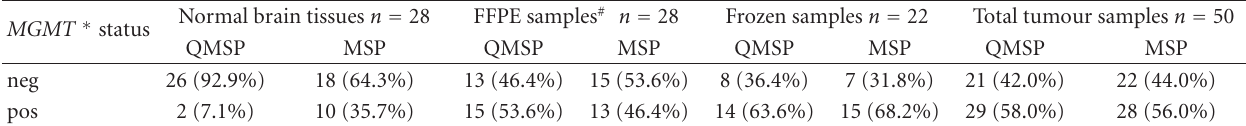
Table 1: MGMT methylation frequencies in normal brain tissues and glioma samples.